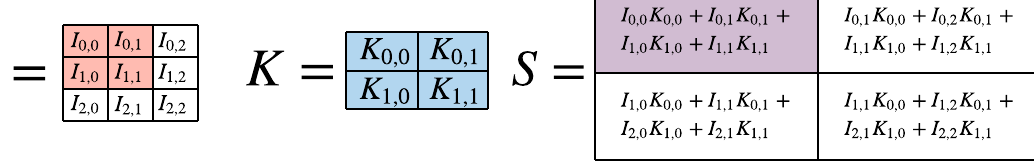
Figure 3. Graphic description of an input image of one channel of 3 × 3, A Kernel of 2 × 2 and the output.